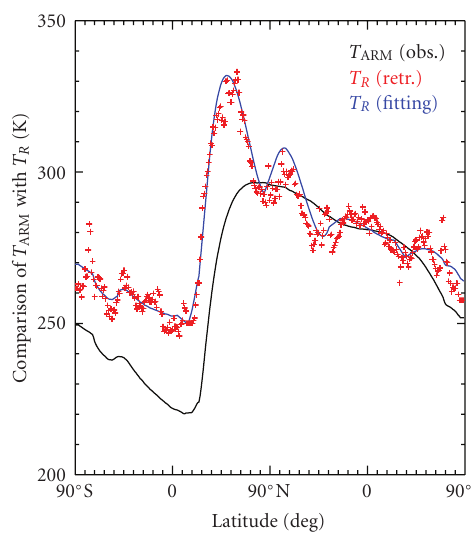
Figure 7: Comparisons of the observed arm temperature, the retrieved and fitted reflector temperatures at 54.4 GHz during one orbit of observations on March 20,